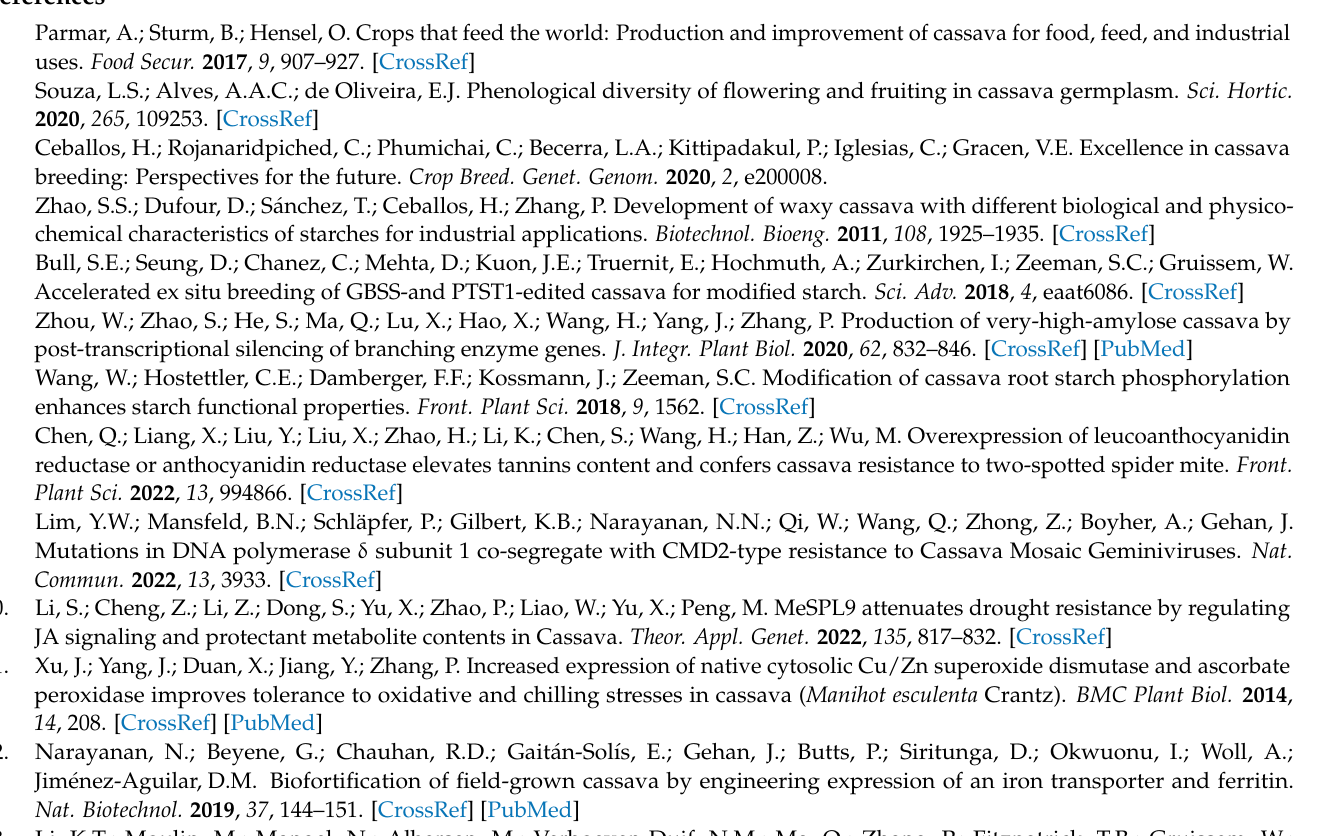
Table S3: Editing effects of MePDS gene by Hi-TOM